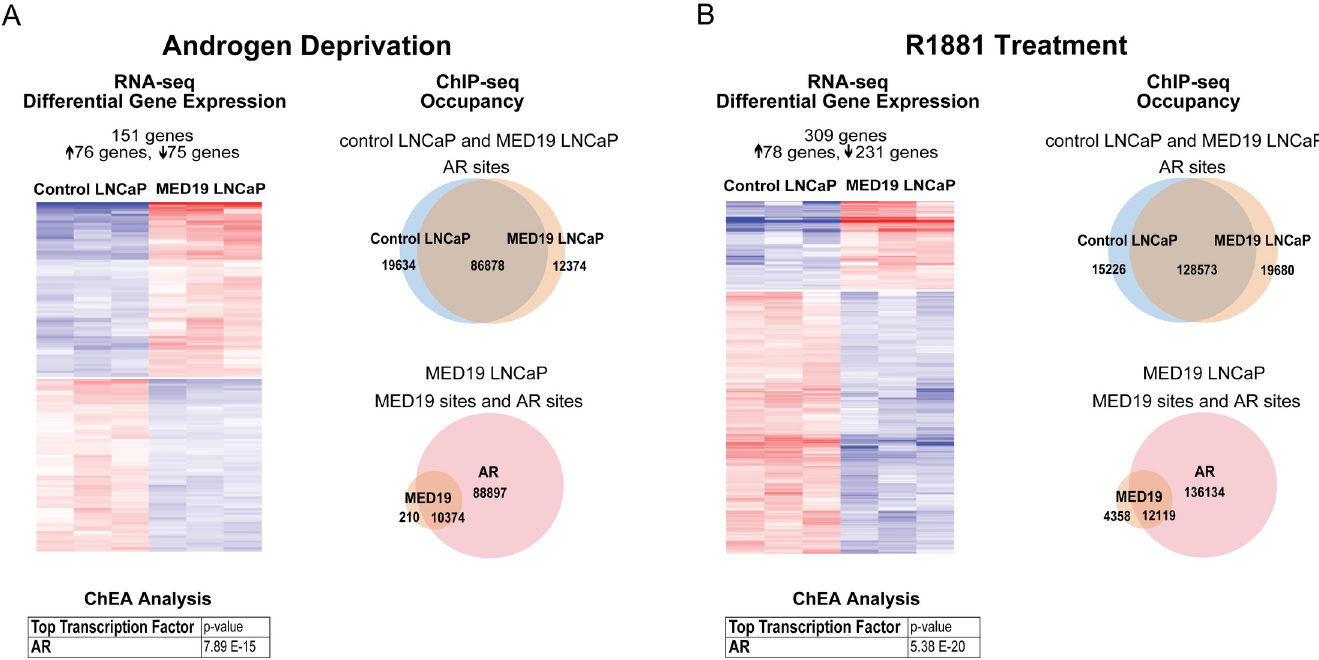
Fig 4. MED19 overexpression causes a selective shift in gene expression and in the AR cistrome under androgen deprivation and with R1881 treatment. MED19 LNCaP cells and control LNCaP cells were cultured under androgen deprivation for 3 days, and cells were treated with ethanol vehicle or R1881 (10 nM for 16 h for RNA-seq and 100 nM for 4 h for ChIP-seq). RNA-seq with ribodepletion was performed in biological triplicate. ChIP-seq for FLAG-MED19, AR, and H3K27ac was performed in biological triplicate, with the exception of ChIP-seq for AR in control LNCaP cells + R1881, where one sample was excluded from the analyses because of low signal. A) (Left) Heatmap of differentially expressed genes with MED19 overexpression (fold change � 1.5, p-adj � 0.05) for androgen deprivation, associated with AR as the top regulatory transcription factor from ChEA. (Right) Number and overlap of occupancy sites under androgen deprivation for AR in control LNCaP cells and MED19 LNCaP cells (top) and for AR and MED19 in MED19 LNCaP cells (bottom). B) (Left) Heatmap of differentially expressed genes with MED19 overexpression (fold change � 1.5, p-adj � 0.05) for R1881 treatment, associated with AR as the top regulatory transcription factor from ChEA. (Right) Number and overlap of occupancy sites with R1881 treatment for AR in control LNCaP cells and MED19 LNCaP cells (top) and for AR and MED19 in MED19 LNCaP cells